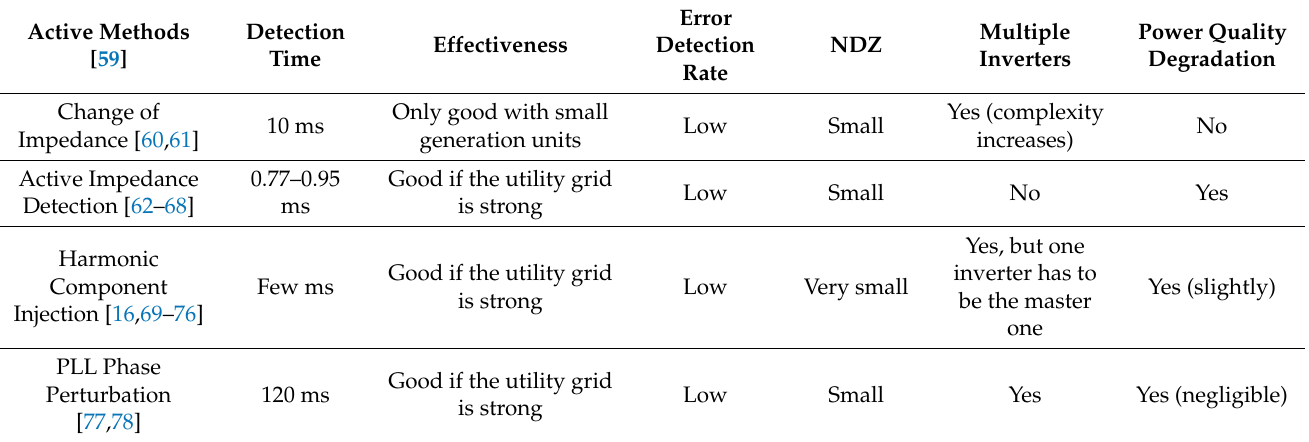
Table 2. Resume of the active islanding methods presented in this